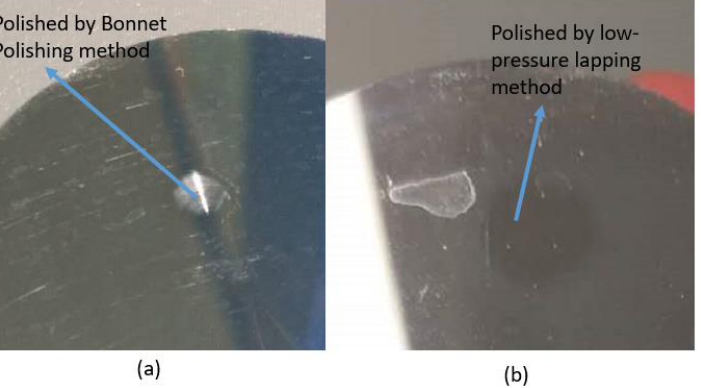
Figure 1. Result of Al6061 mirror surface polished by ( a ) Bonnet polishing method and ( b ) our low-pressure lapping method.